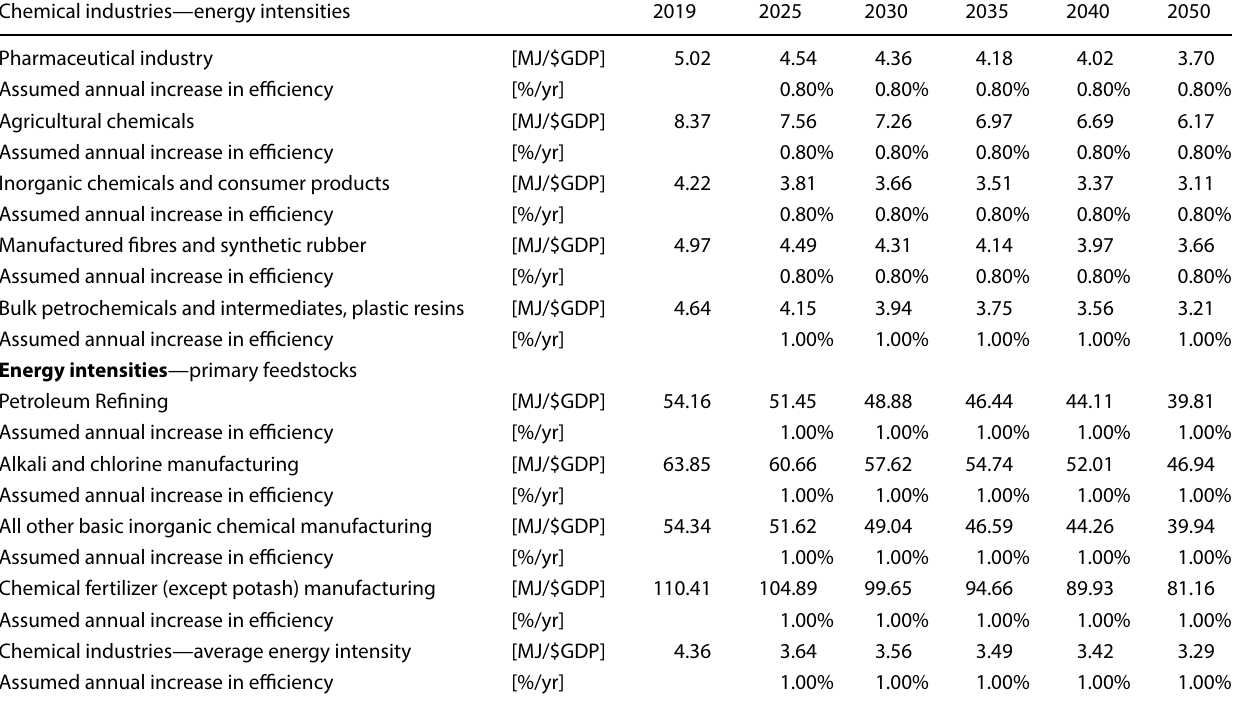
Table 3 Assumed energy intensities for sub-sectors of the chemical